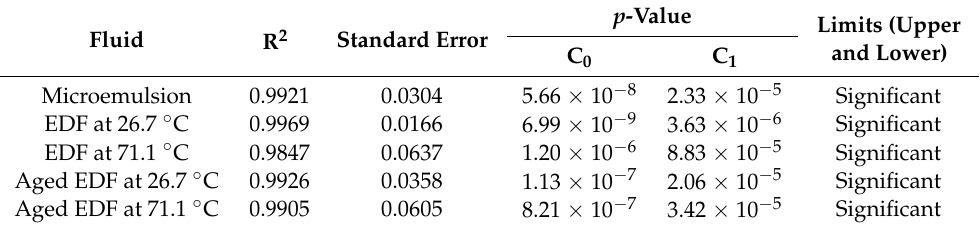
Table 6. Statistical analyses of the viscosity curves for the EDF fluid and microemulsion.